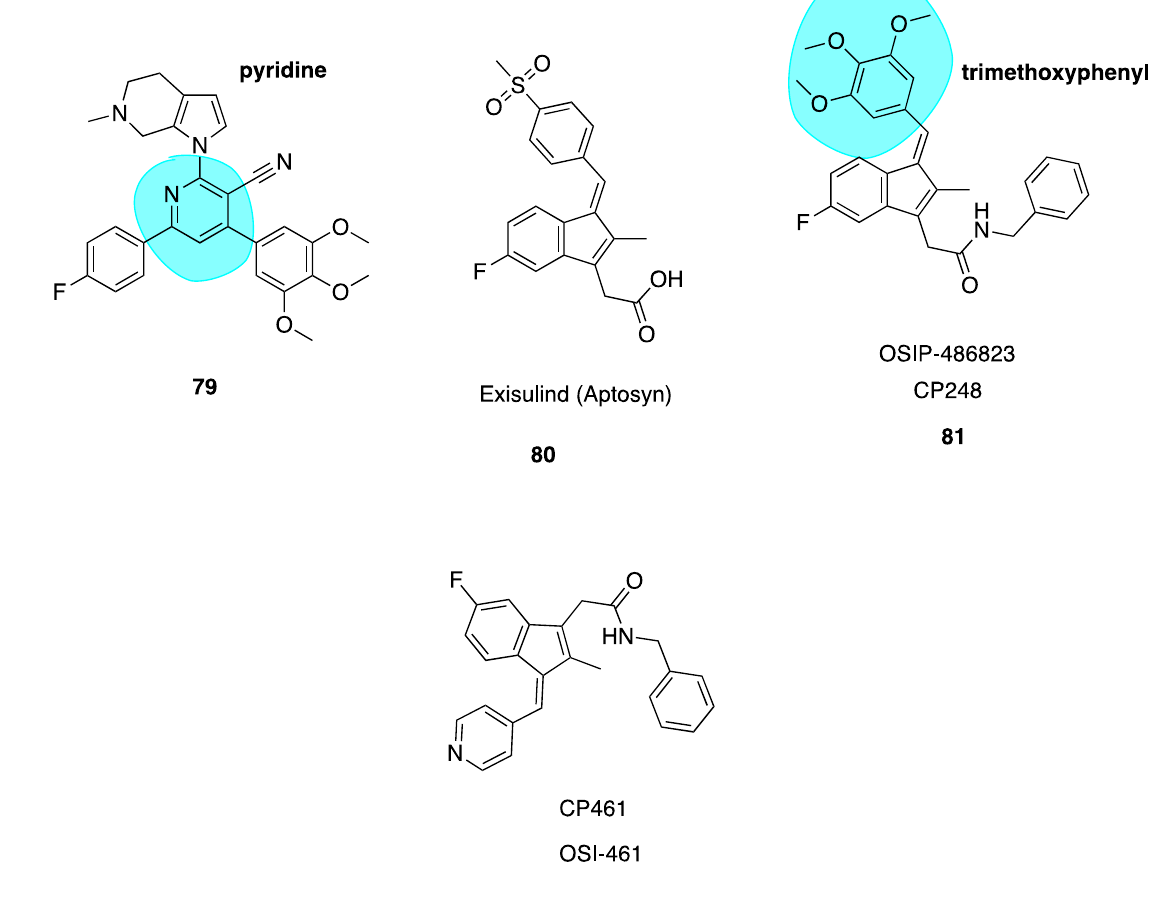
Figure 12. Crolibulin derivative 79 , exisulind, and exisulind derivatives 81 – 82 .